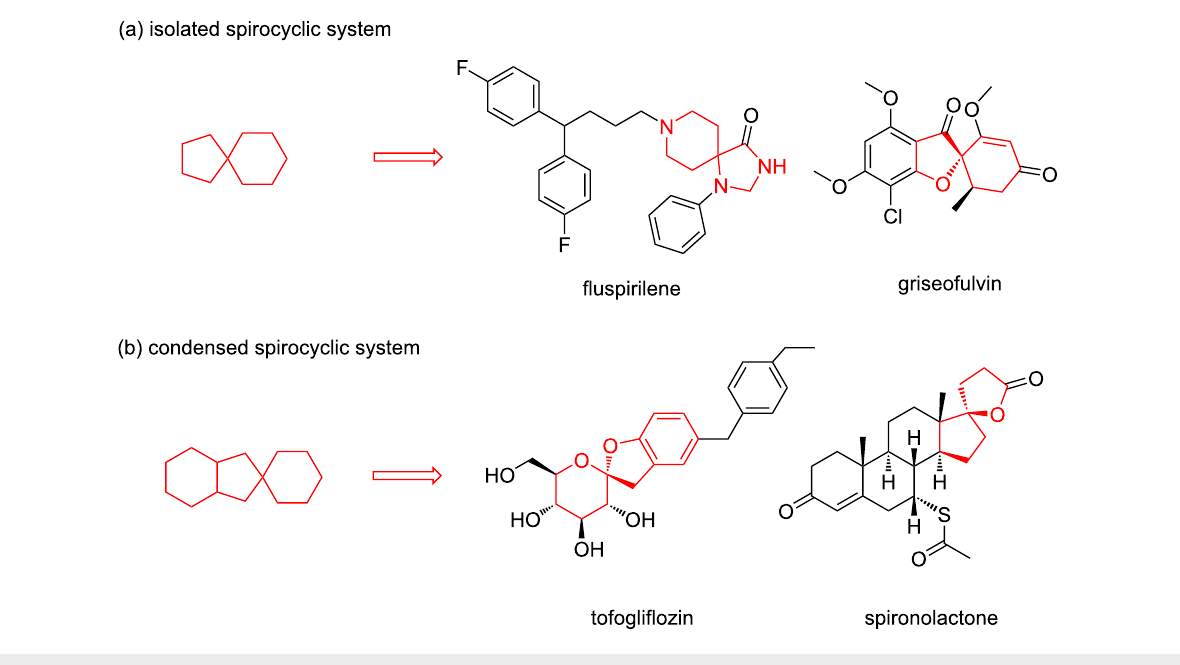
Figure 1: Chemical structure of representative approved drugs containing a spirocyclic